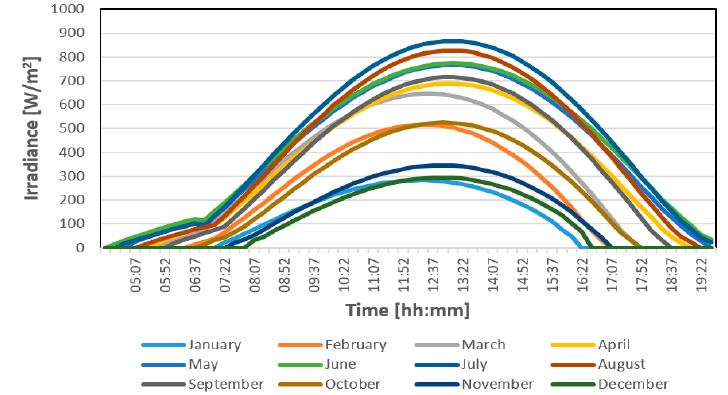
Figure 12. Daily irradiance in Ferrara for each month.